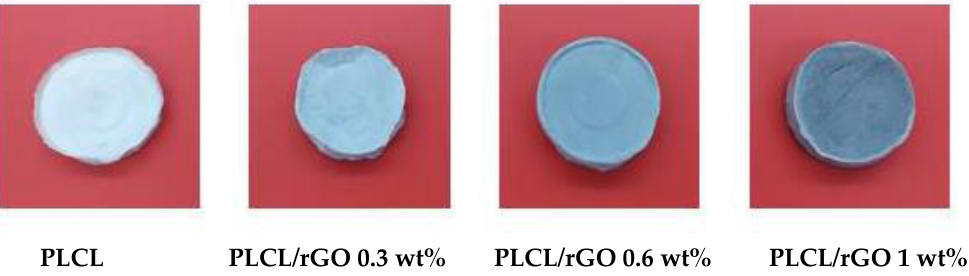
Figure 1. From left to right, samples of pure PLCL and PLCL/rGO at 0.3, 0.6, and 1 wt% rGO.